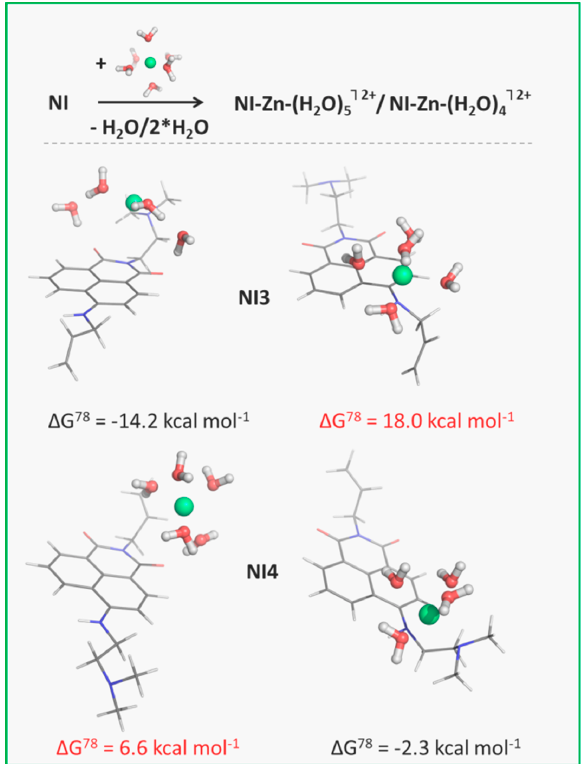
Figure 11. Modeled reaction between NI3 / NI4 and hydrated Zn 2 + ions, as well as possible NI3-Zn 2 + and NI4-Zn 2 + complexes. The free energies ∆ G 78 (in kcal mol − 1 ) for the complex formation reactions are shown.